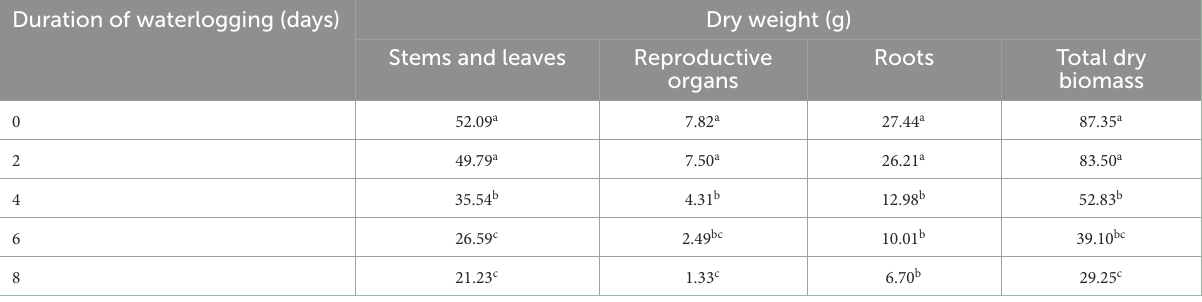
TABLE 1 Dry weight of stems and leaves, reproductive organs (floral buds, flowers, and fruits), and roots of cape gooseberry ( Physalis peruviana L.) subjected at an age of 2 months to waterlogging of different durations at 50 days after waterlogging started. Duration of waterlogging